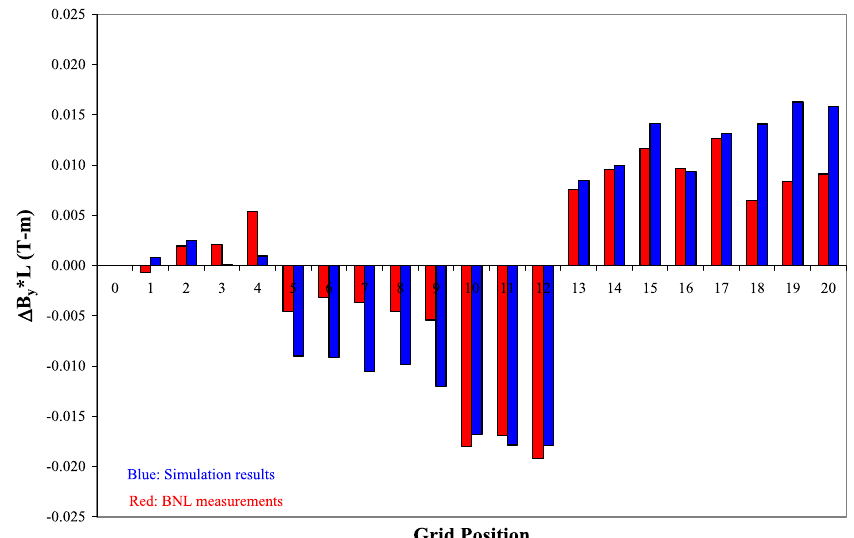
FIG. 11. (Color) Simulation and test data from the integrated dipole field on